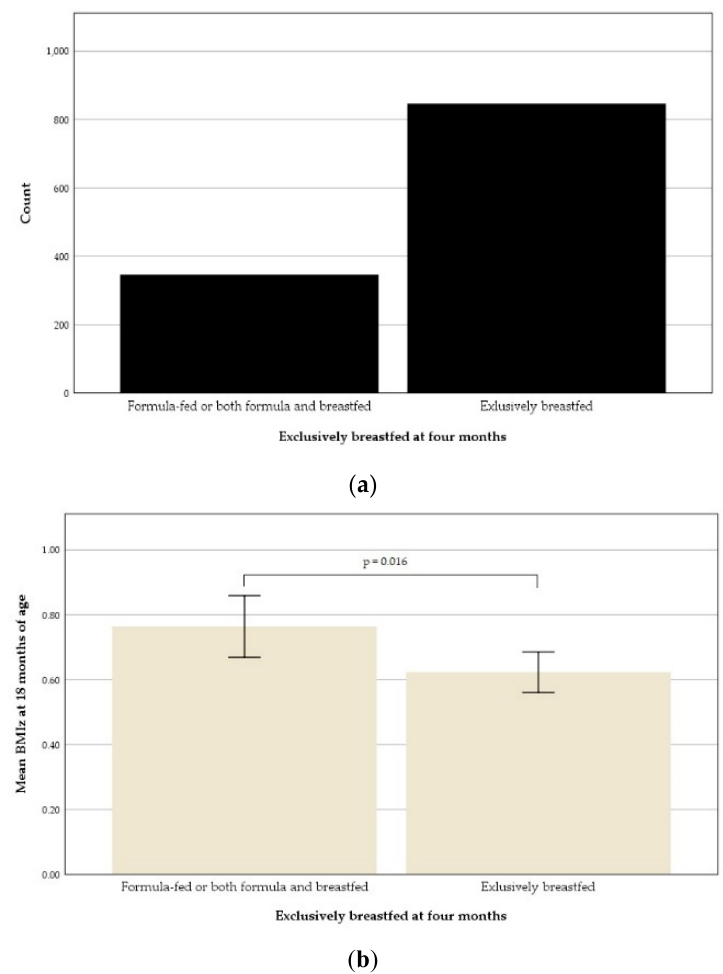
Figure 6. Exclusive breastfeeding at four months of age: ( a ) Distribution shown as block graph; ( b ) An error bar graph illustrating the mean body-mass index z -score (BMIz) at 18 months of the formula fed or both formula and breastfed and of the exclusively breastfed children.